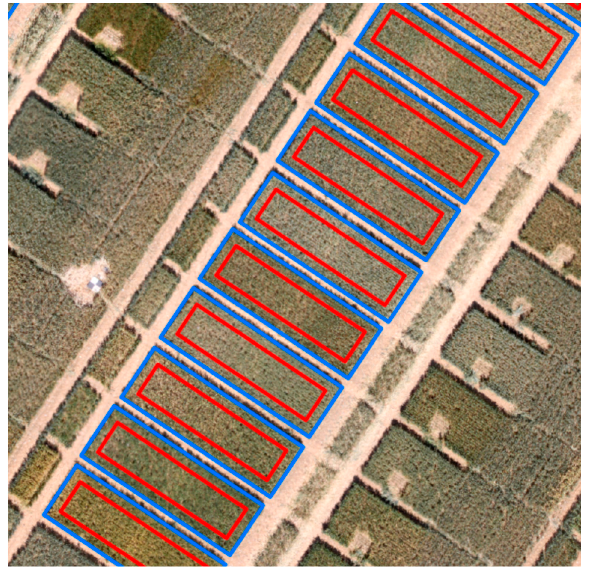
Figure 6. Plot borders before ( blue ) and after ( red ) buffering isolating each plot within the field in order to extract heights.